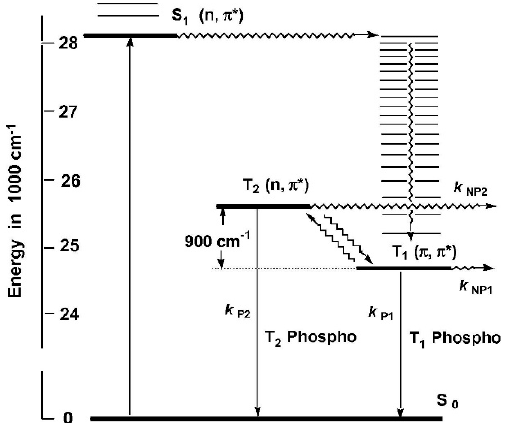
Figure 18. Energy level scheme showing the relaxation processes for 70 in a p -dichlorobenzene matrix: k P1 and k NP1 are, respectively, the radiative and nonradiative rate constants of T 1 ; k P2 and k NP2 are those of T 2 . Reprinted from [70], Copyright 2014, with permission from Elsevier.